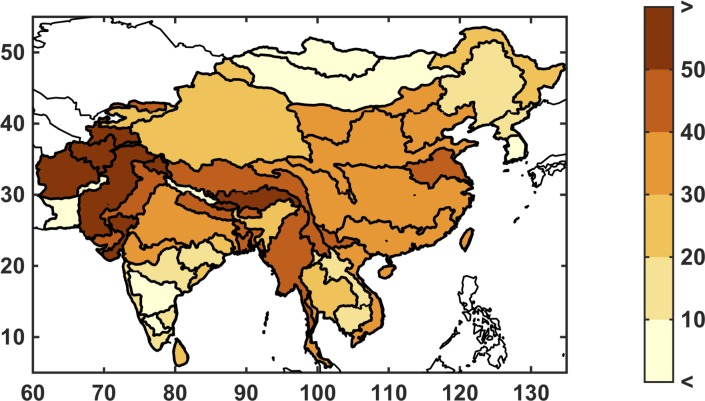
Baseline unmet water requirement (%) for the study region at the ASR level.Unmet requirement is defined as total consumptive use divided by the total water requirement.